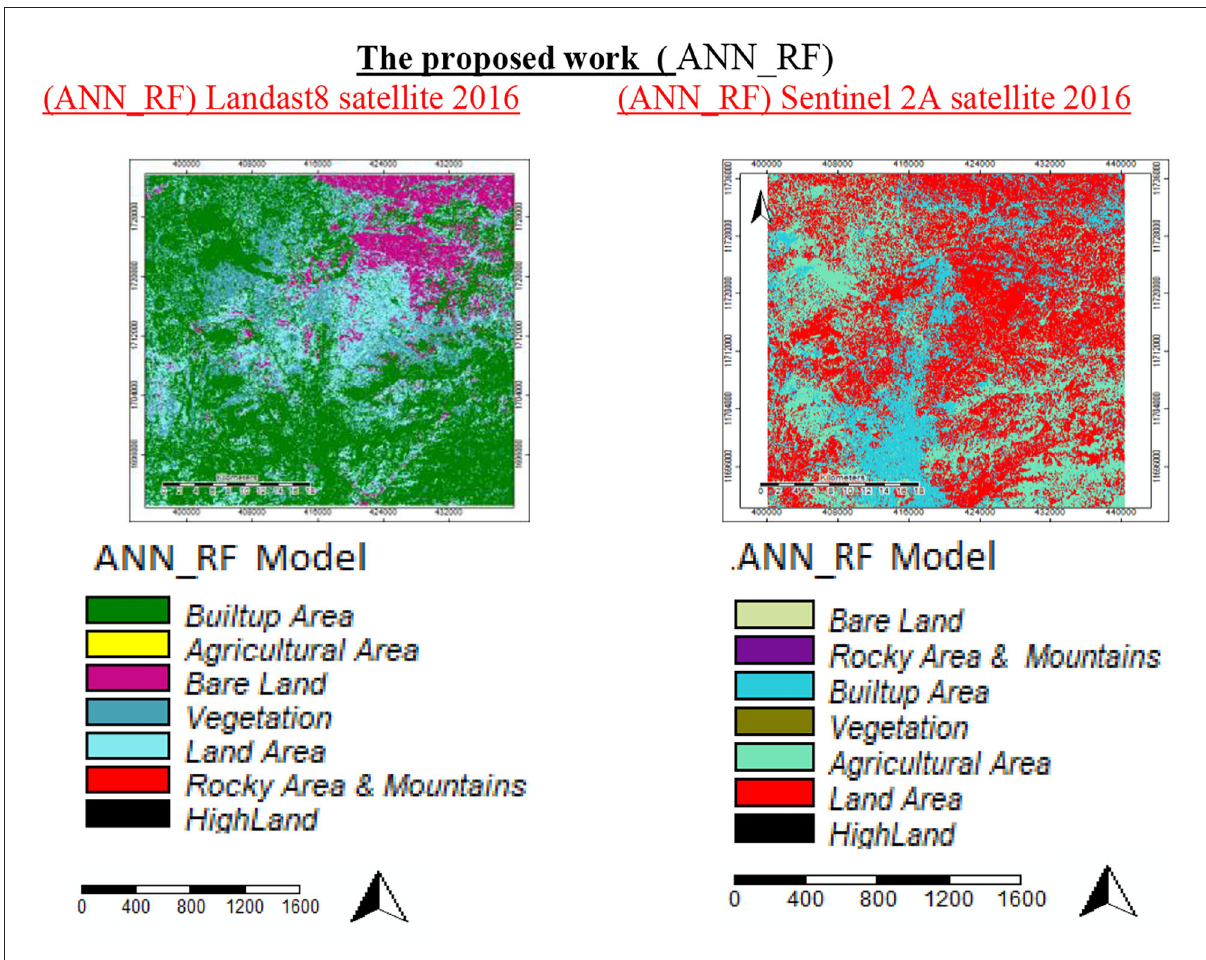
FIGURE8 Classification of land use/land cover with the proposed work (ANN_RF).